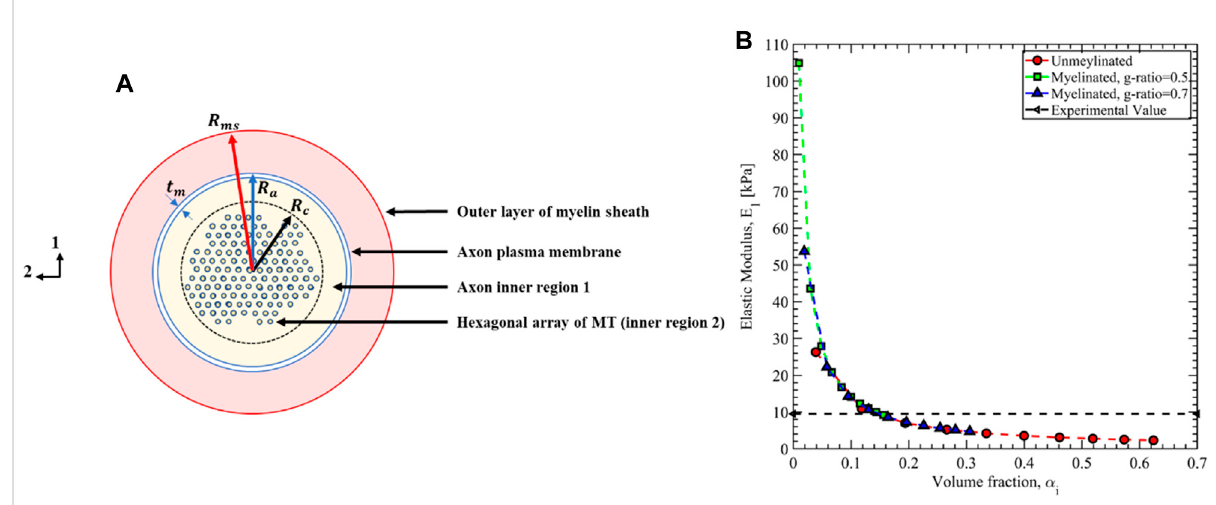
FIGURE 15 (A) Cross-sectional view of the axon microstructure. (B) The axon ’ s effective transverse elastic modulus is estimated using the inverse rule of mixture based on the composite theory.